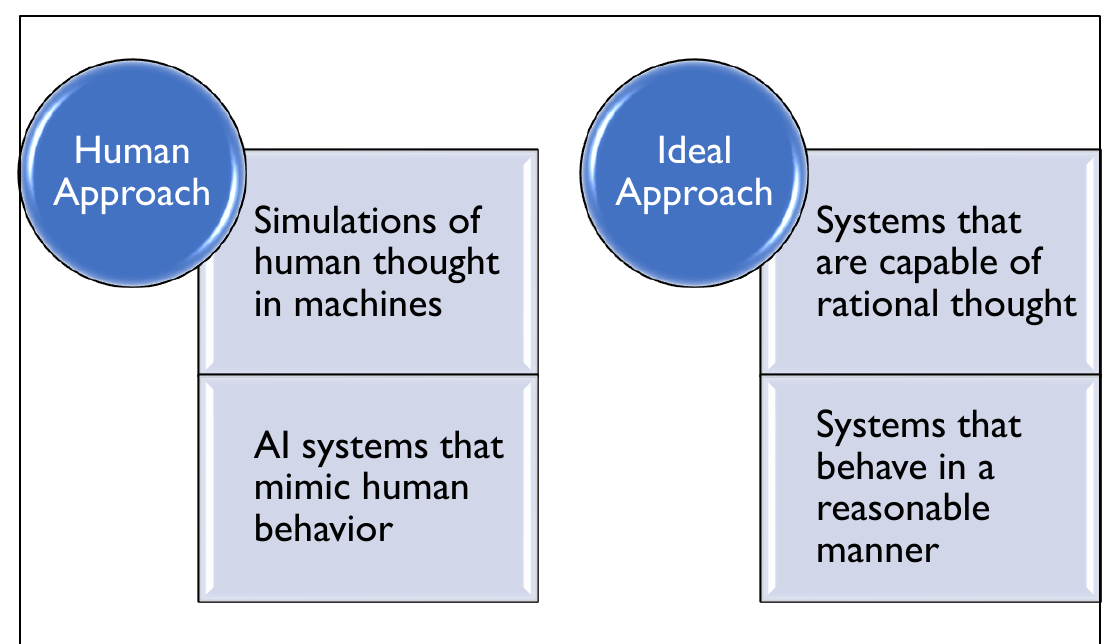
Figure 1. Potential definitions of AI .